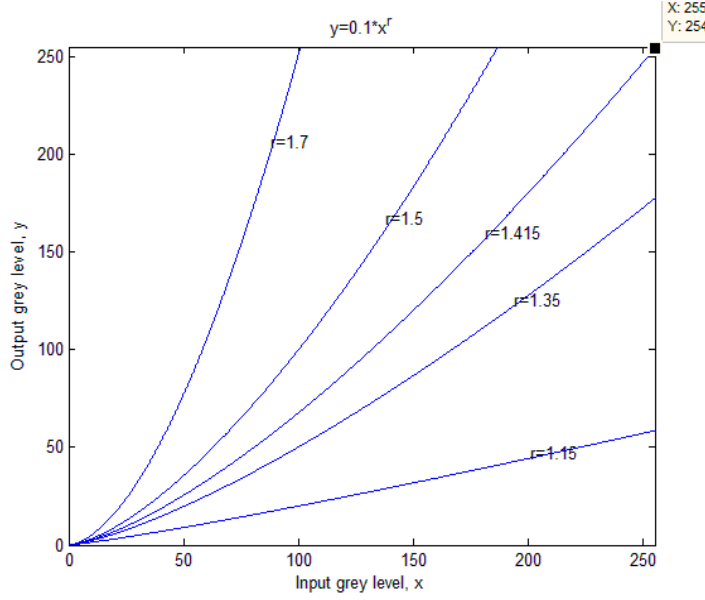
Figure 3. The plots of the power-law equation with different r values.